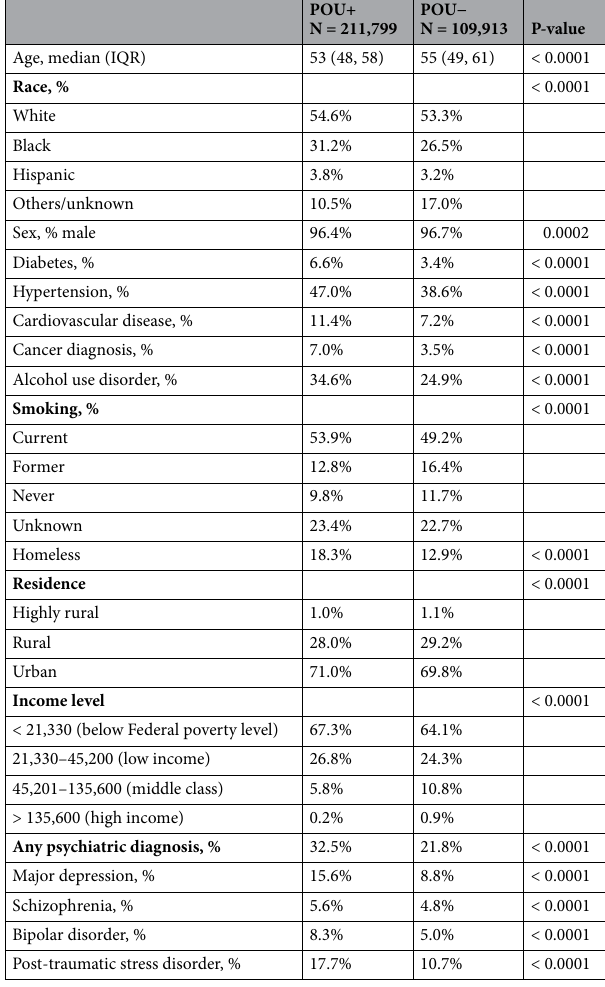
Table 2. Baseline characteristics of persons with and without any acute or chronic prescription opioid use. POU, prescription opioid use.